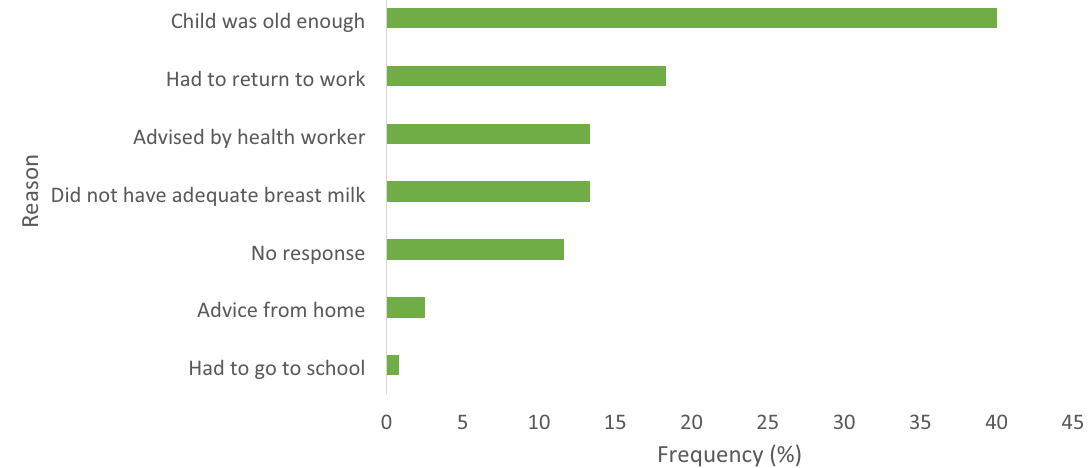
Figure 1. Reason for introduction of complementary food at a particular age.